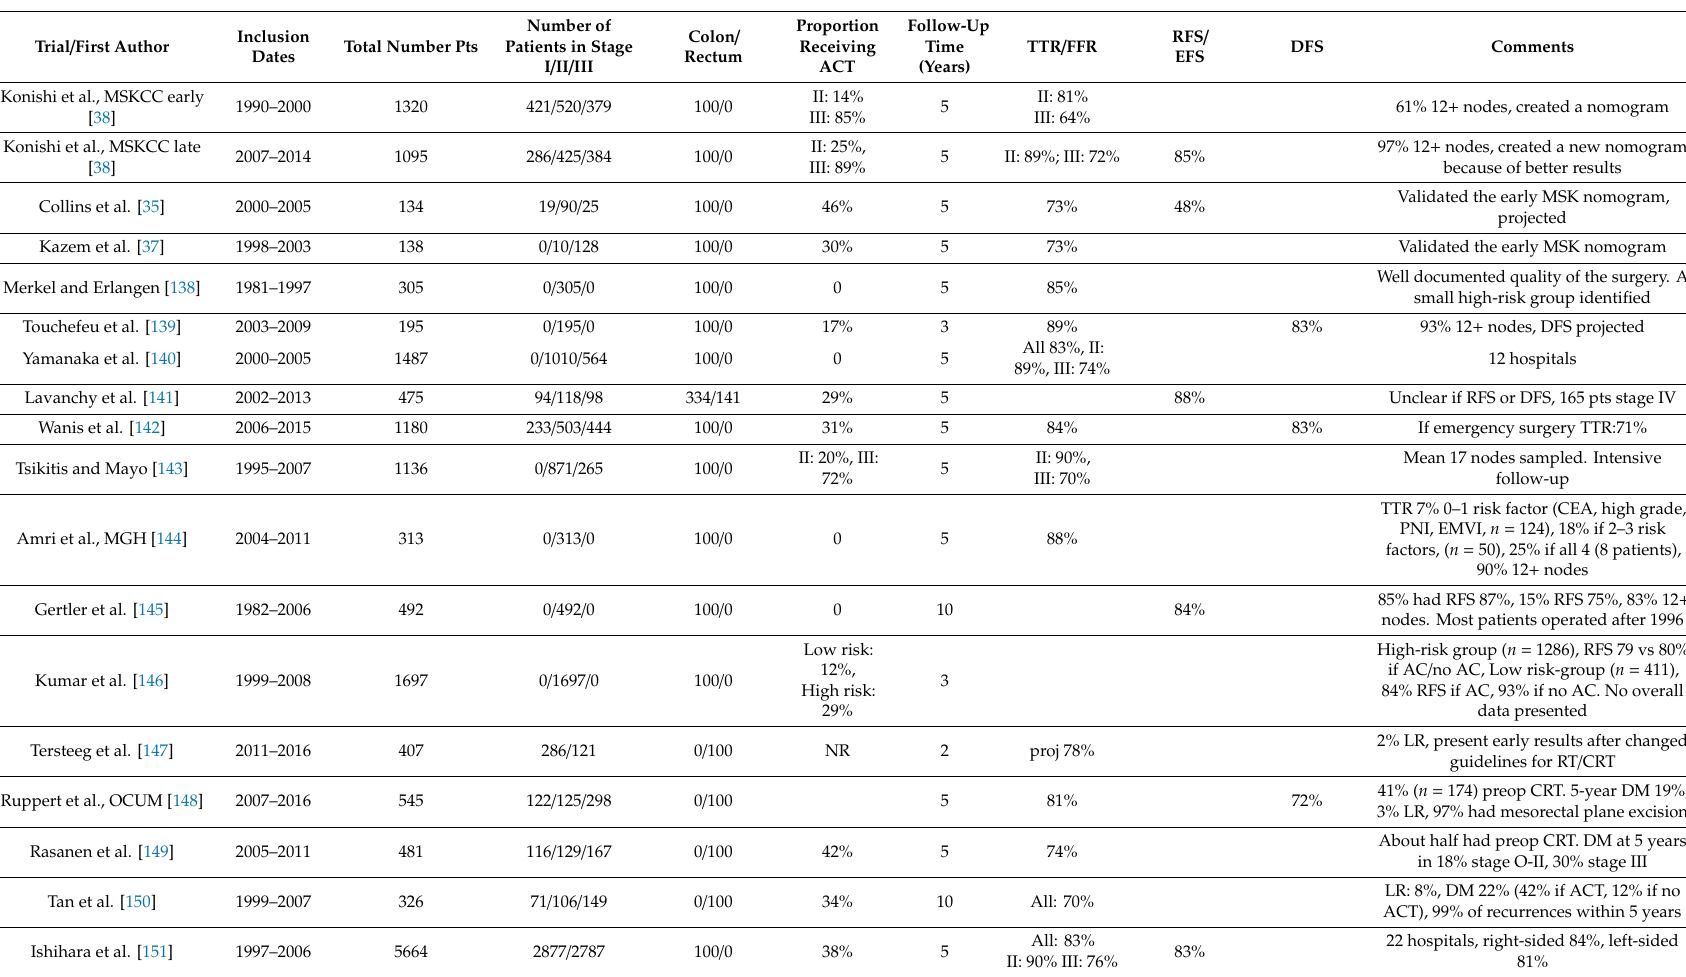
Table 6. Time to recurrence rate / freedom from recurrence, recurrence- and disease-free survival in surgical or population-based series of colon or rectal